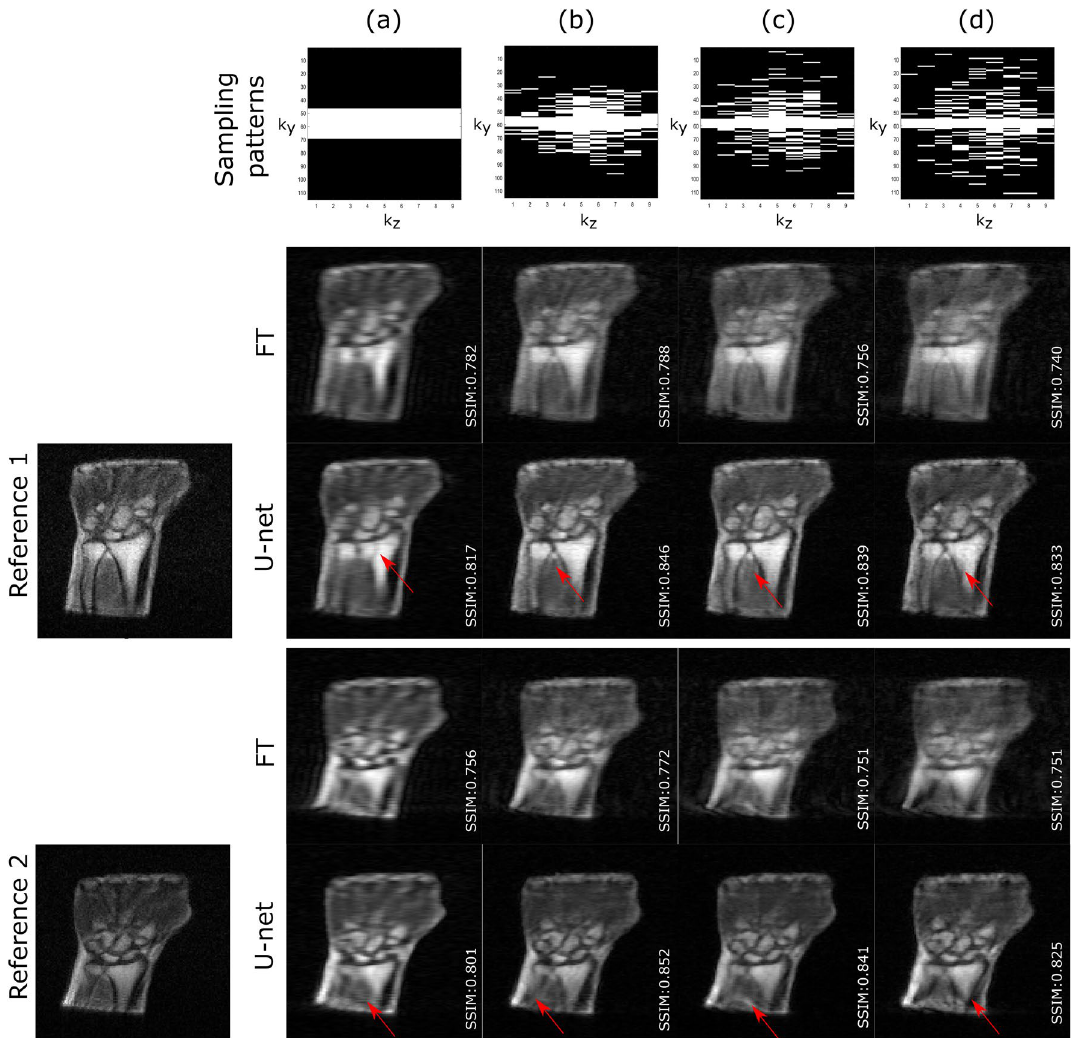
Figure 4. Impact of sampling patterns on the reconstruction performance of the magnitude images. ( a ) CL = 23 σ y = 0, ( b ) CL = 7 σ y = 0.10, ( c ) CL = 7 σ y = 0.15 and ( d ) CL = 7 σ y = 0.20. Acceleration rate = 5. Although the model succeeded in fully removing local artifacts in the background, red arrows show examples of local artifacts still present inside the